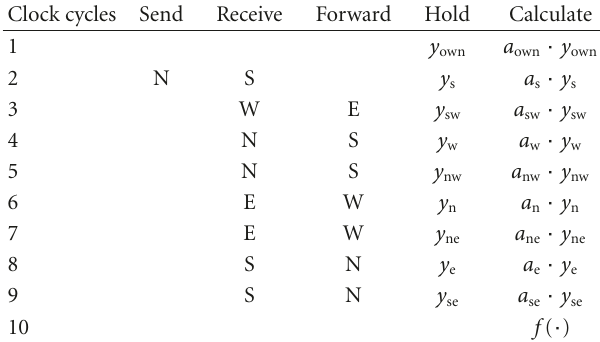
Table 3: The serial broadcasting scheme yields in a same sequence of computation as in the semiparallel